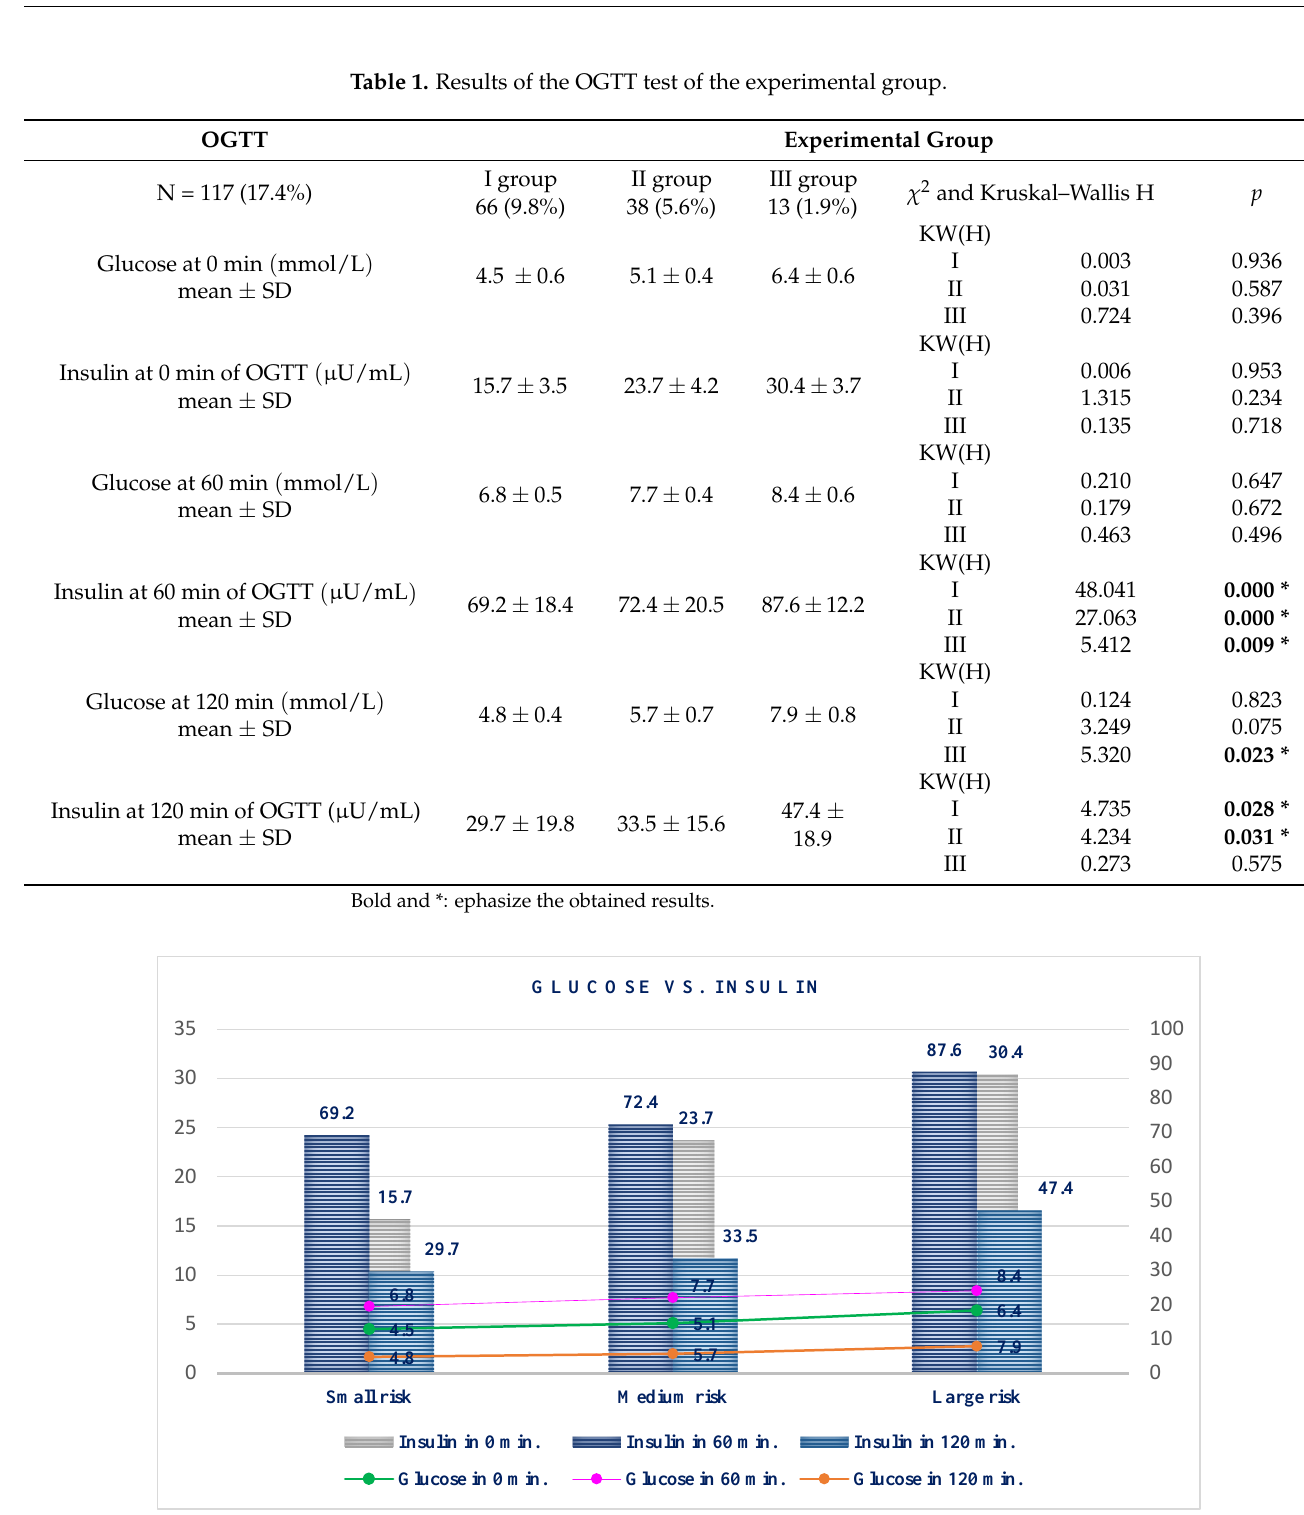
Table 1. Results of the OGTT test of the experimental group.